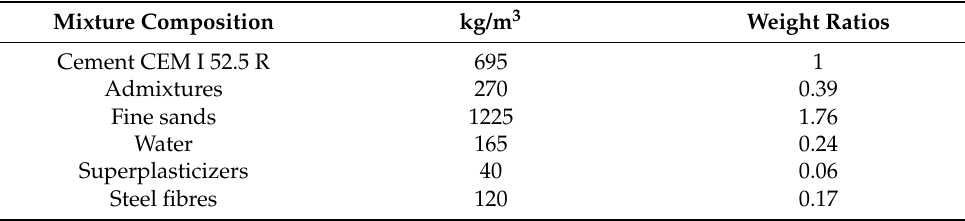
Table 1. Composition of the reference mixture with a defined aggregate ratio.